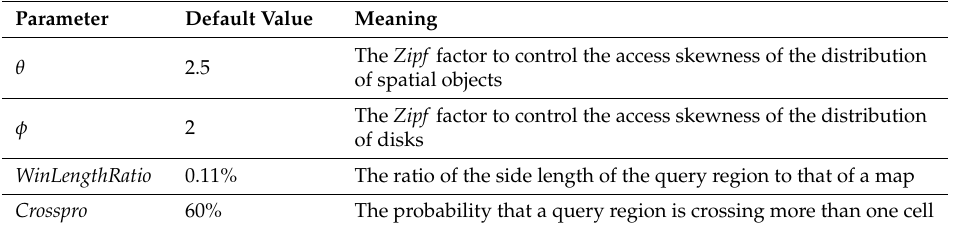
Table 1. Performance parameters and their default values.